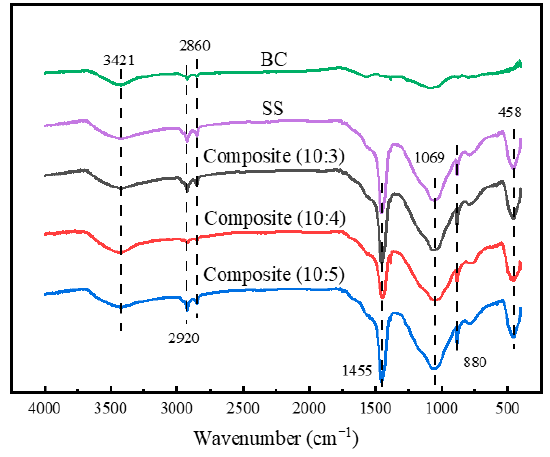
Figure 4. FTIR spectra of the BC/SS composites with different mass ratios.